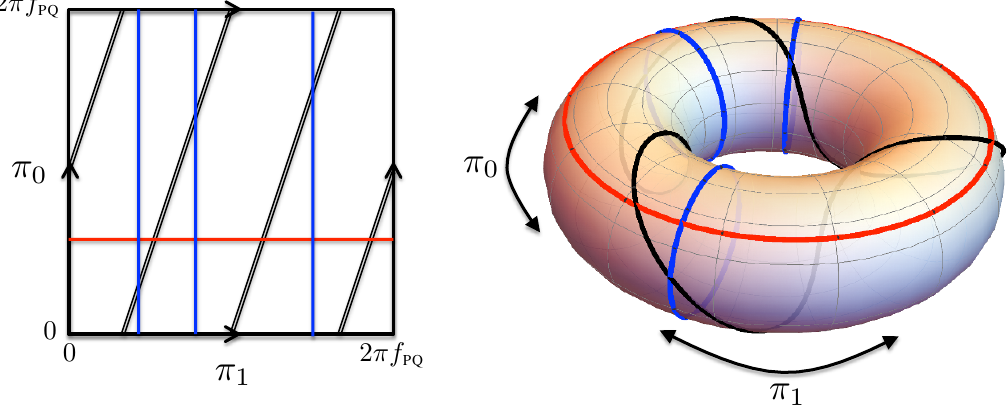
Figure 1 . For the model with N + 1 = 2 complex scalar (cid:12)elds the pseudoscalar (cid:12)eld space ( (cid:25) 0 ; (cid:25) 1 ) is topologically equivalent to a 2-torus. For (cid:15) = 0 and QCD instanton e(cid:11)ects neglected, there is no potential for ( (cid:25) 0 ; (cid:25) 1 ); taking (cid:15) = 0 induces a potential, leaving a single (cid:13)at direction, which is 6 represented by the black line; and at the QCD epoch, instanton e(cid:11)ects lift also this (cid:13)at direction. Along the (cid:13)at direction (black line) the axion (cid:12)eld covers a [0 ; 2 (cid:25)f a ) (2.10) while the (cid:12)eld (cid:25) n 2 completes q N (cid:0) n cycles (2.7) corresponding to its PQ charge (2.3). The three blue lines indicate three (cid:25) 0 -strings, each connected to one domain wall; the red line indicates a single (cid:25) 1 -string connected to three domain walls; and the black line indicates an a -string. See discussion in section